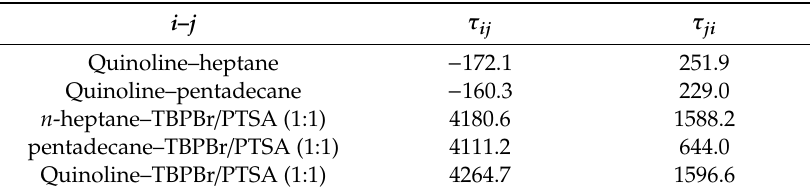
Table 8. The values of NRTL binary interaction